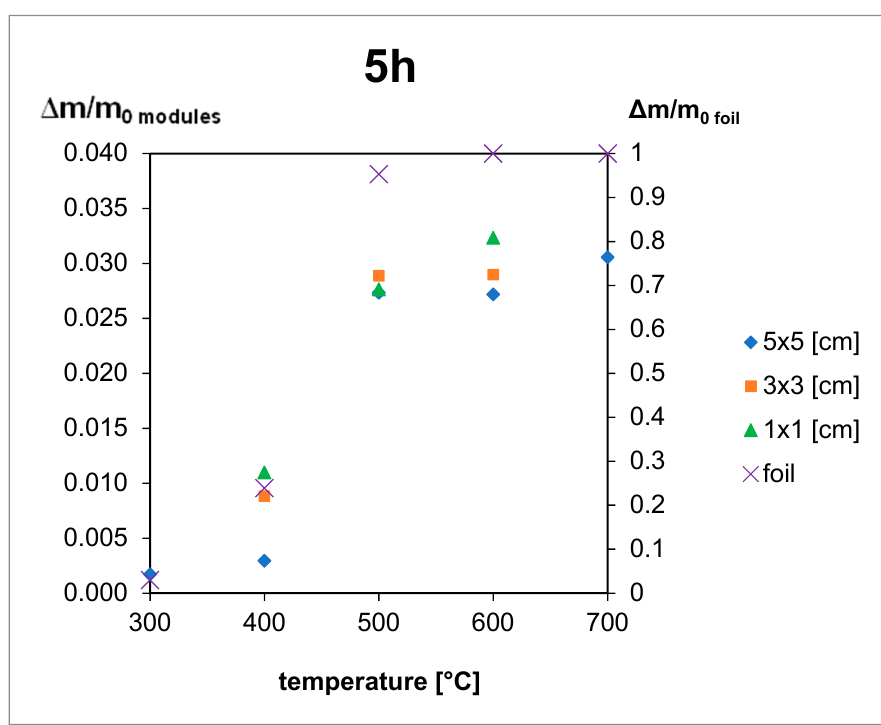
Figure 6. Results of the thermal treatment of module pieces and EVA foil for 3 h.